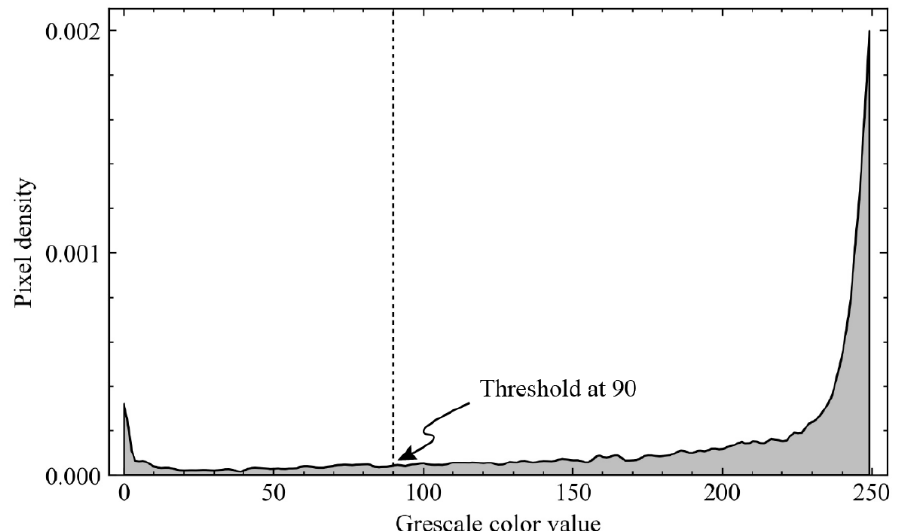
Figure 4. Bimodal distribution of greyscale values of the crack image based on OTSU thresholding algorithm.